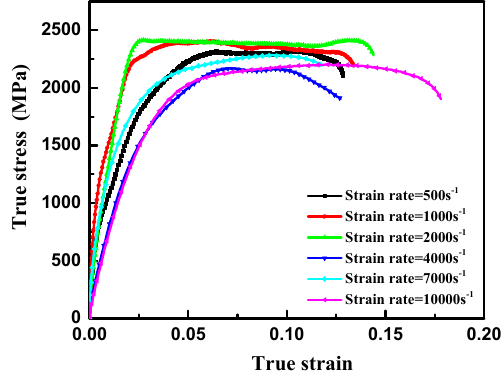
Figure 4. True stress–strain curves from SHPB tests at 25 °C.